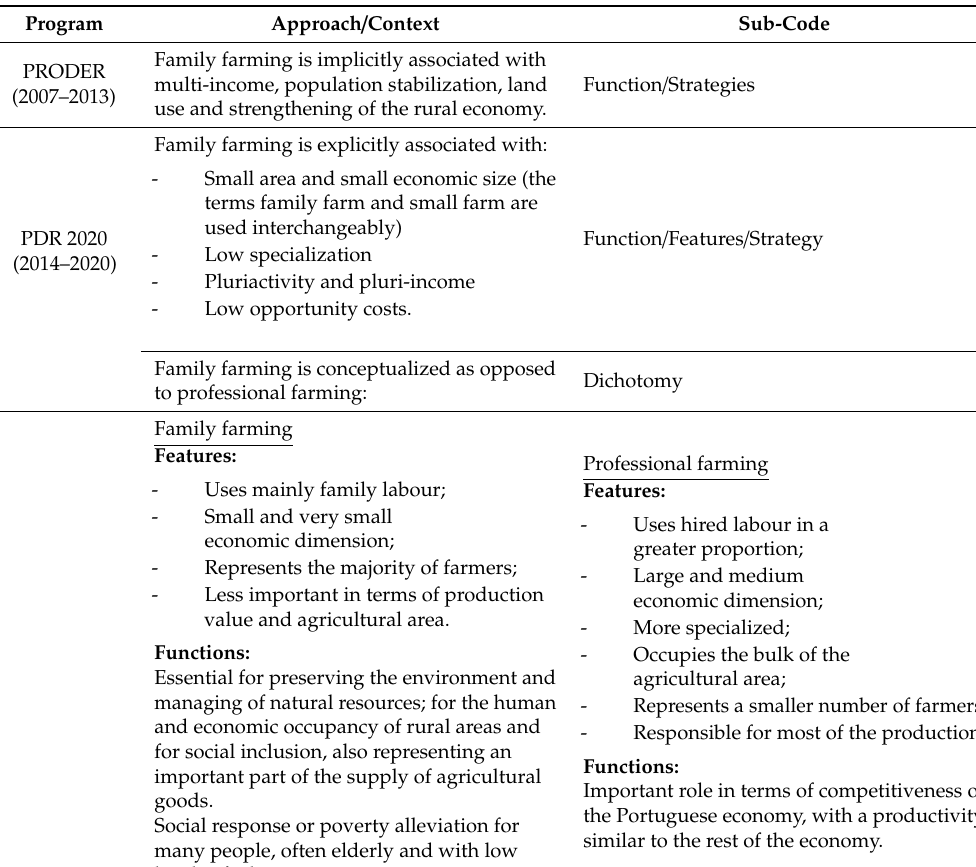
Table 4. Conceptual references to family farming in the Portuguese Rural Development